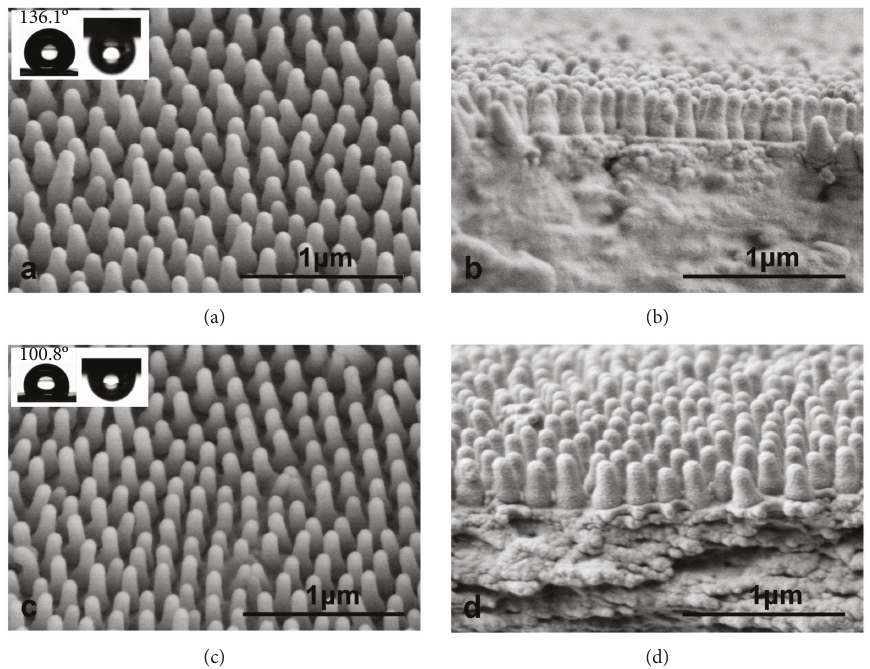
Figure 2: SEM images of protrusions and optical photographs of the contact angles on the cicada Cryptotympana atrata wing surfaces. (a) The structure of the sample collected from Zhejiang with a contact angle of 136.1 ° and large contact angle hysteresis. (b) The cross section of the sample collected from Zhejiang showing the regular arrangement of protrusions. (c) The structure of the sample collected from Fujian with a contact angle of 100.8 ° and large contact angle hysteresis. (d) The cross section of the sample collected from Fujian showing the quasi-ordered arrangement of